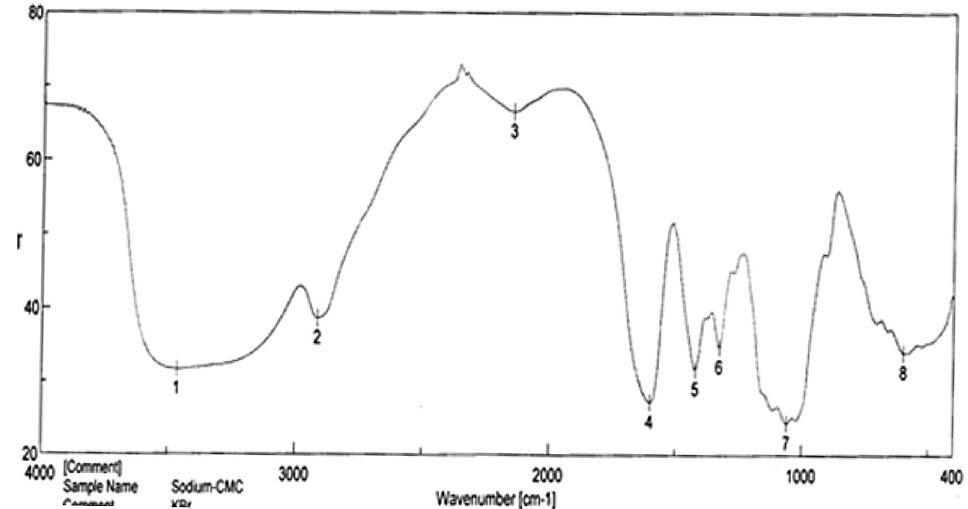
FIGURE 7 (d) - FTIR Spectroscopic analysis of